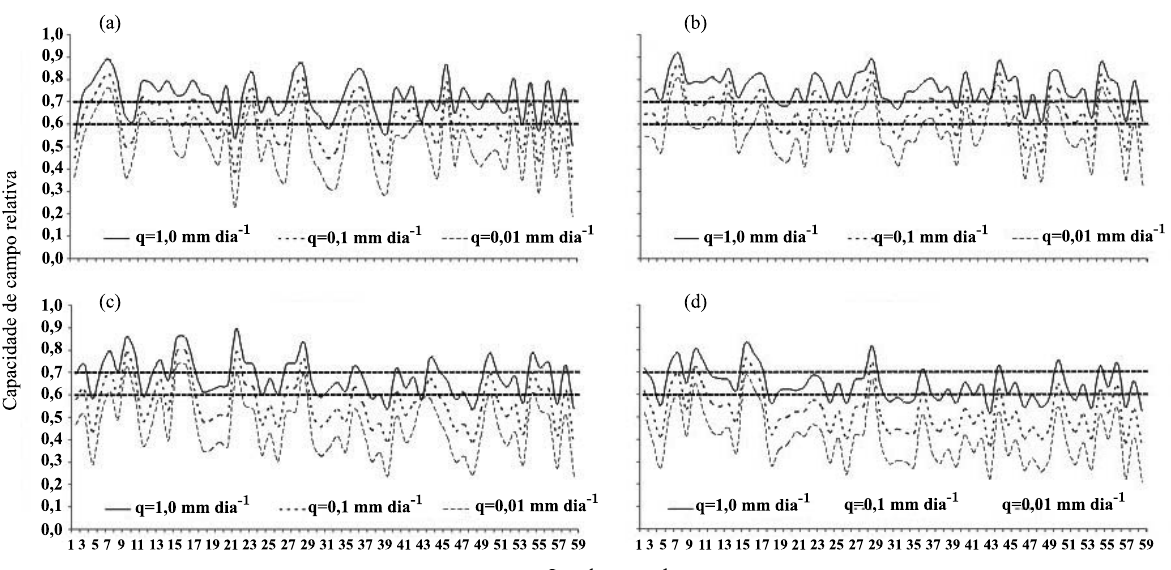
Figura 9. Variação espacial da capacidade de campo relativa nas profundidades de 0,2 (a), 0,4 (b), 0,6 (c) e 0,8 m (d), correspondente às densidades de fluxo de 1,0, 0,1 e 0,01 mm dia -1